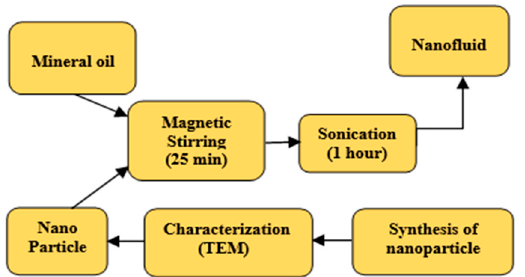
Figure 2. Flow chart illustration for preparation of nanofluids.